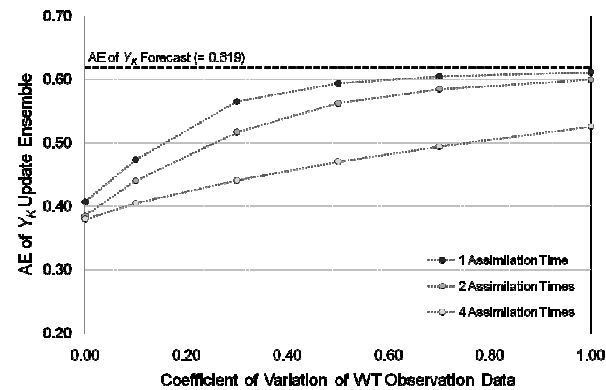
Figure 9. The increase of AE (i.e., the decrease in conditioning to the true 2 e of AE (i.e., the decrease in conditioning to the true Y K field) with increasing values of CV Fig. 9. The increase of AE (i.e., the decrease in conditioning to the of the WT observation data, for the cases when one, two, and four assimilation times are used. 3 observation data, for the cases when one, two, and four assimilation times are used. true Y K field) with increasing values of CV of the WT observation data, for the cases when one, two, and four assimilation times are used. Fig. 7. Spatial distribution of EP for the updated Y K ensemble using data from 24 observation wells sampled 4 times during the 365-day . Spatial distribution of EP for the updated Y K ensemble using data from 24 observation wells sampled 4 ensemble using data from 24 observation wells sampled 4 period, with the CV of observation data set to 0.0. Figure 7. Spatial distribution of EP for the updated 2 times during the 365-day period, with the CV of observation data set to 0.0. 3 day period, with the CV of observation data set to 0.0.